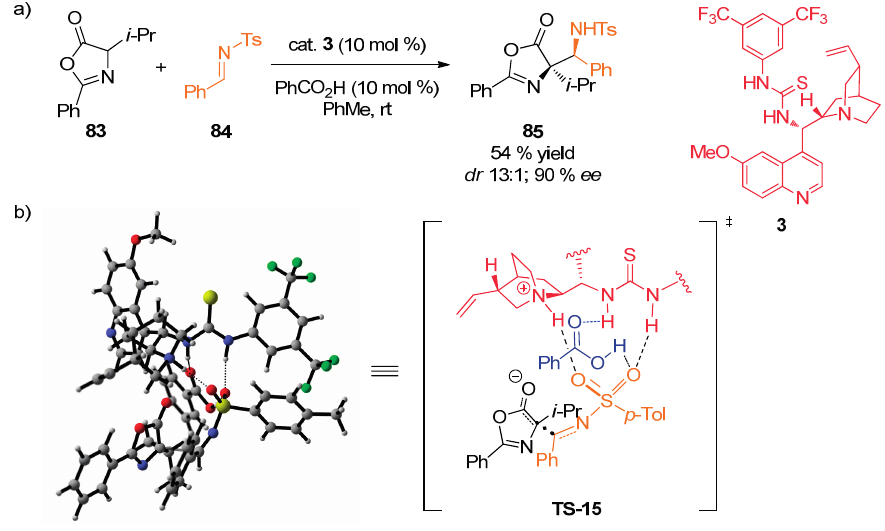
Figure 22. Mannich reaction of oxazolone 83 and N -protected imine 84 ( a ); proposed transition state model ( b